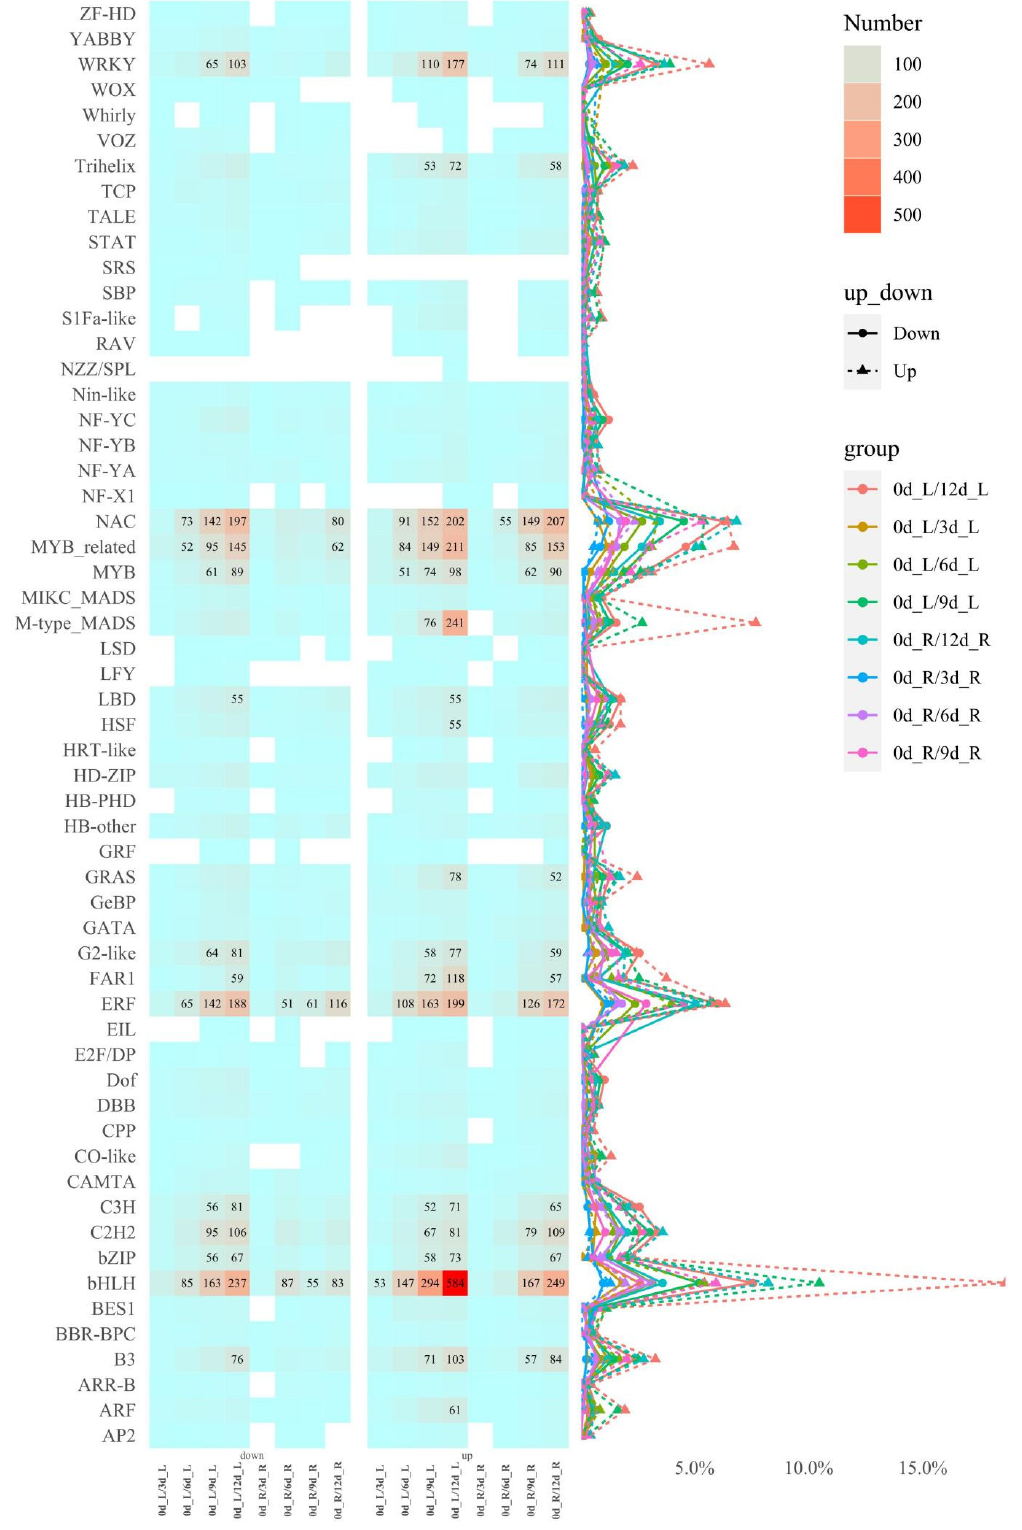
Figure 3. Heatmap and dotted line diagram of differentially expressed genes (DEGs) of transcription factors (TFs) in different periods. Note: The value in the heatmap is the number of DEGs corresponding to the comparison combination, and the value of DEG >50 is displayed. The left heatmap is downregulated, and the right heatmap is upregulated; the percentage value represents the ratio of up/downregulation of TFs in different